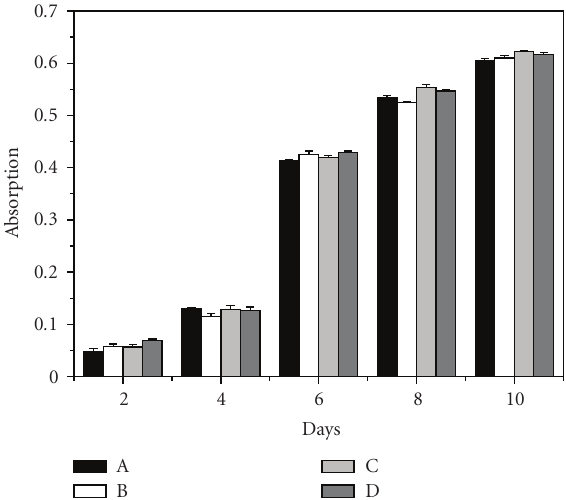
Figure 1: Chondrocyte proliferation in alginate hydrogels cultured in (a) medium supplemented with 1% ITS plus 2% FBS, (b) medium with 1% ITS plus 4% FBS, (c) medium with 1% ITS plus 8% FBS, or (d) medium with 10% FBS after various culture times. Values represent the mean and standard deviation, n =